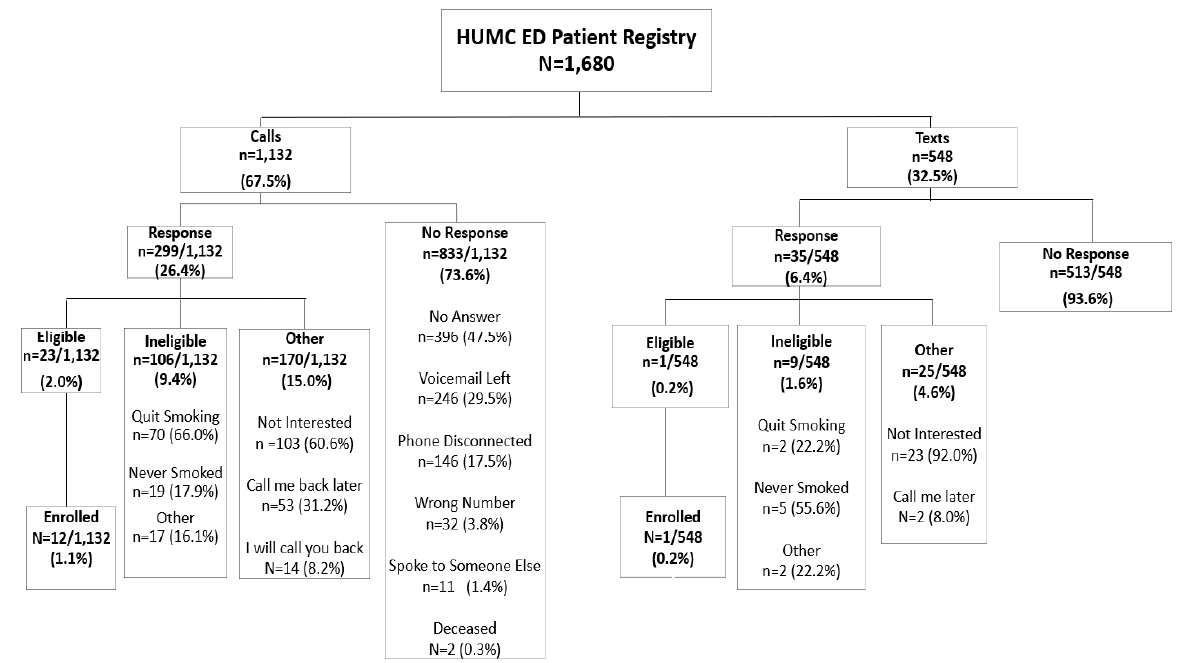
Figure 1. Consort diagram showing the flow of patients that responded to call or text. January 2019–June 2019.